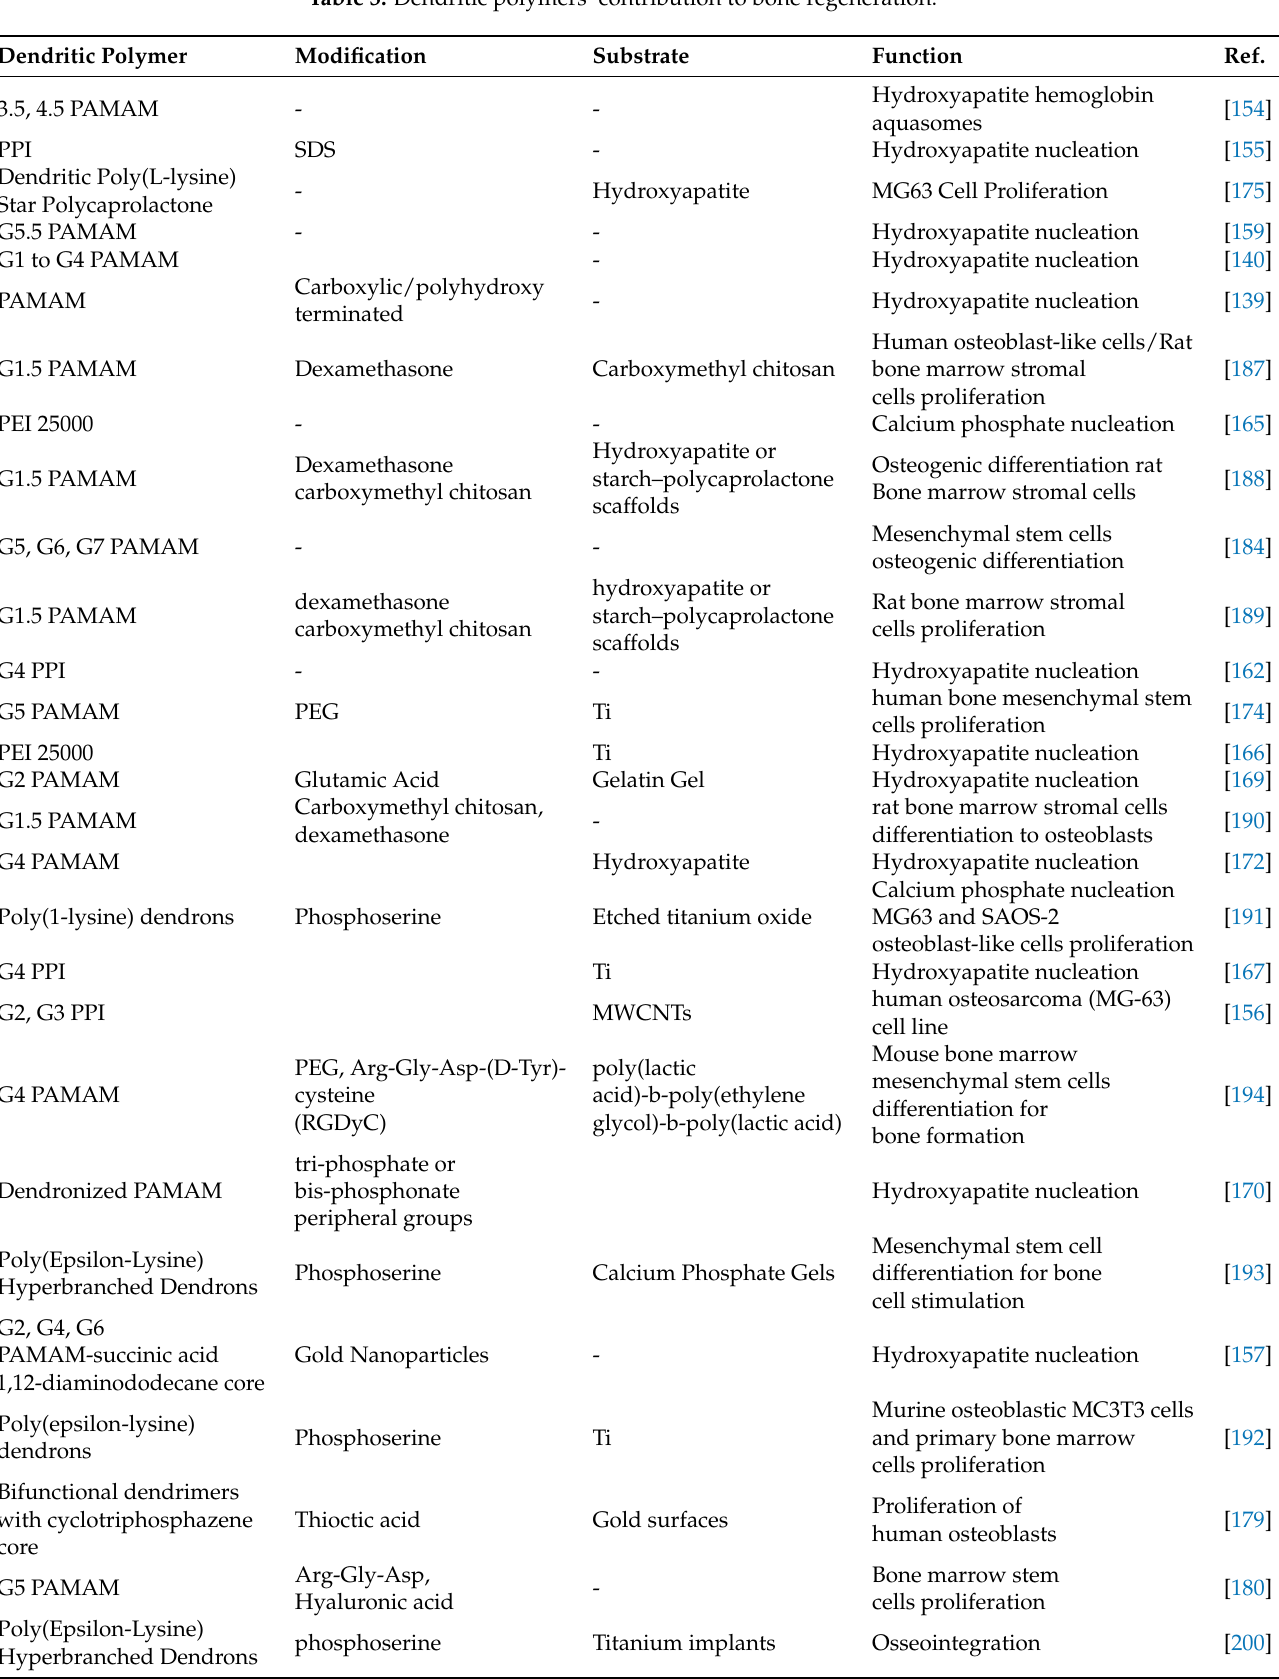
Table 3. Dendritic polymers’ contribution to bone regeneration. Dendritic